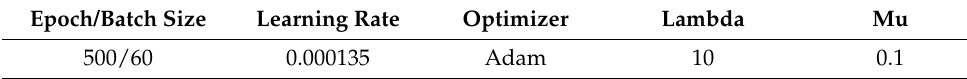
Table 3. Training parameter settings of SDGAN generating system.